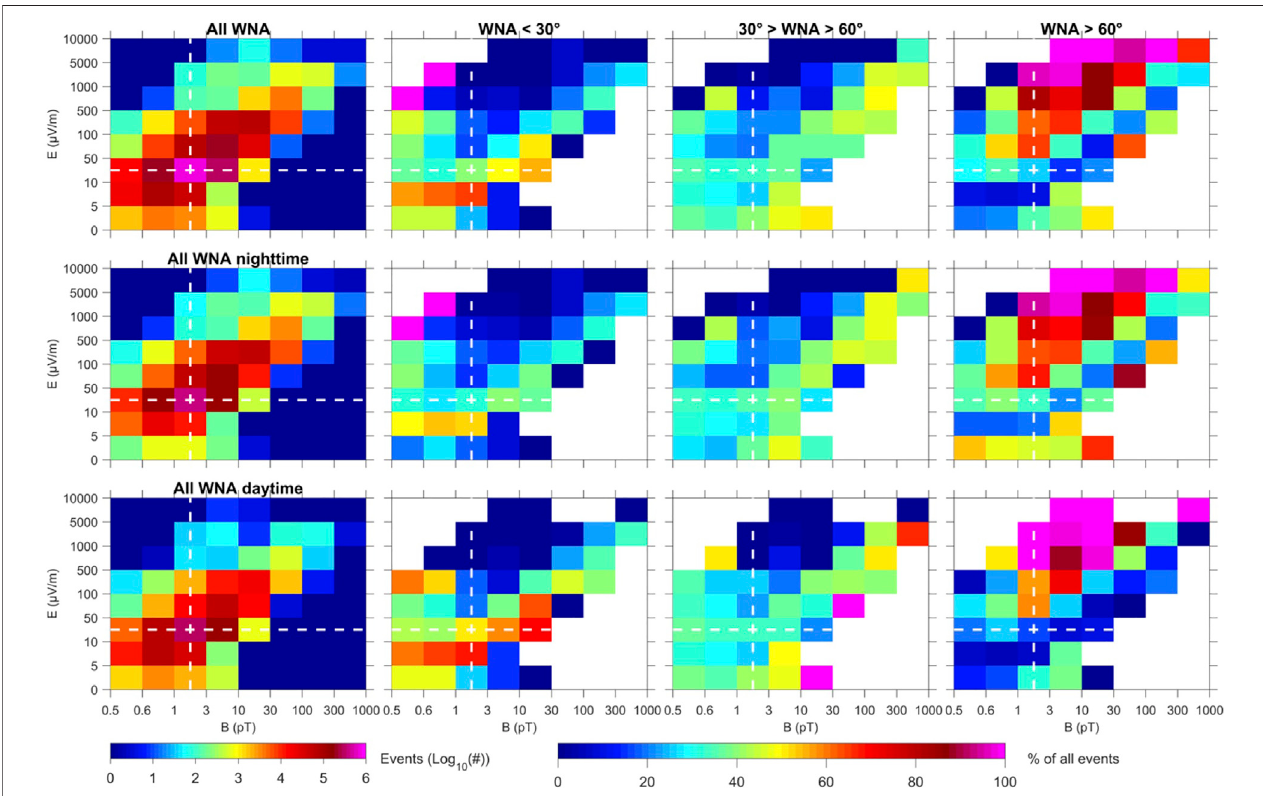
FIGURE 4 | Distributions of the wave-normal angle with respect to electric fi eld and magnetic fi eld amplitudes for (column 1) all (0 ° ≤ θ < 90 ° ), (column 2) low ( θ ≤ 30 ° ),(column 3)moderate (30 ° < θ ≤ 60 ° ),and (column4)large( θ > 60 ° ) wavenormal angles and for(row1) alltimes, (row2)nighttime only,and (row3)daytime only. (1column)numbersofdataisplottedwhile(twotofourcolumns)thepercentage ofdataisshown.Whilelinesindicatethemeanofthealltimesandallwavenormalangle data in the top left corner. These white lines are replicated on all plots for facilitating the